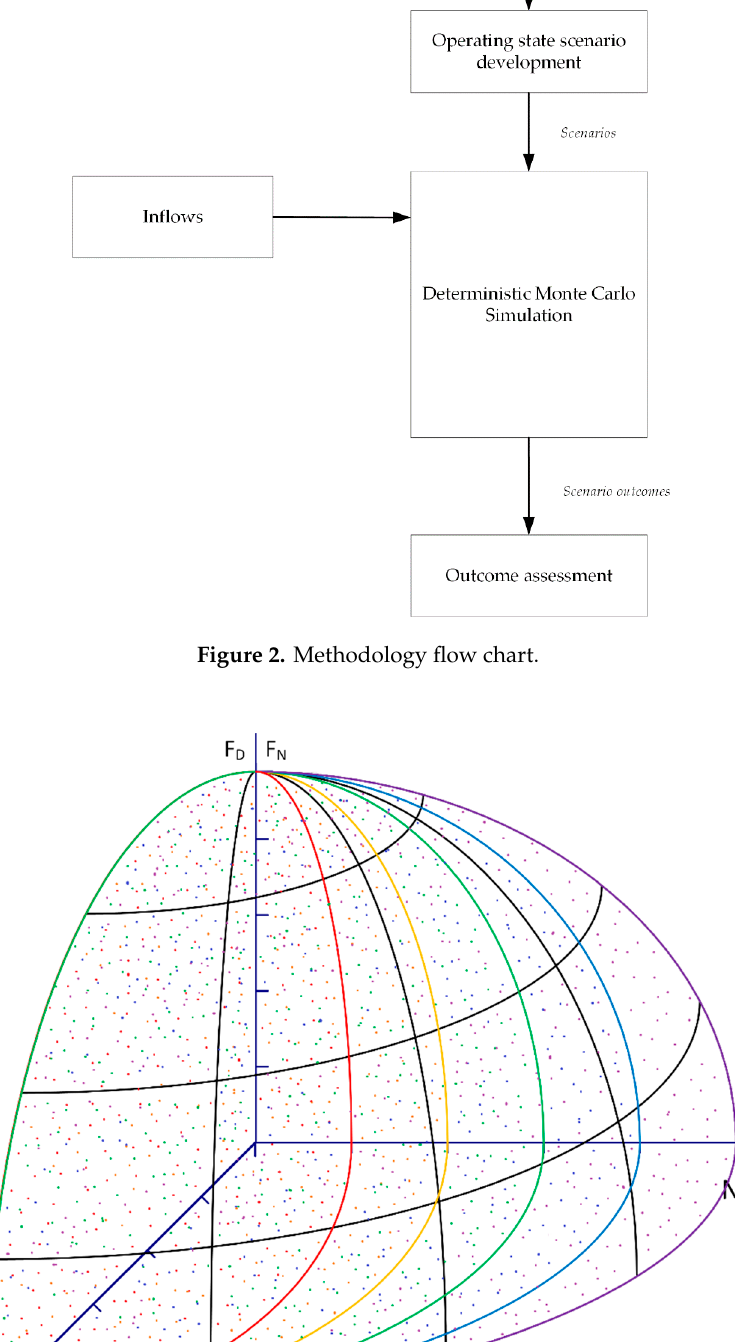
Figure 3. Deterministic Monte Carlo sampling from within the possibility space.